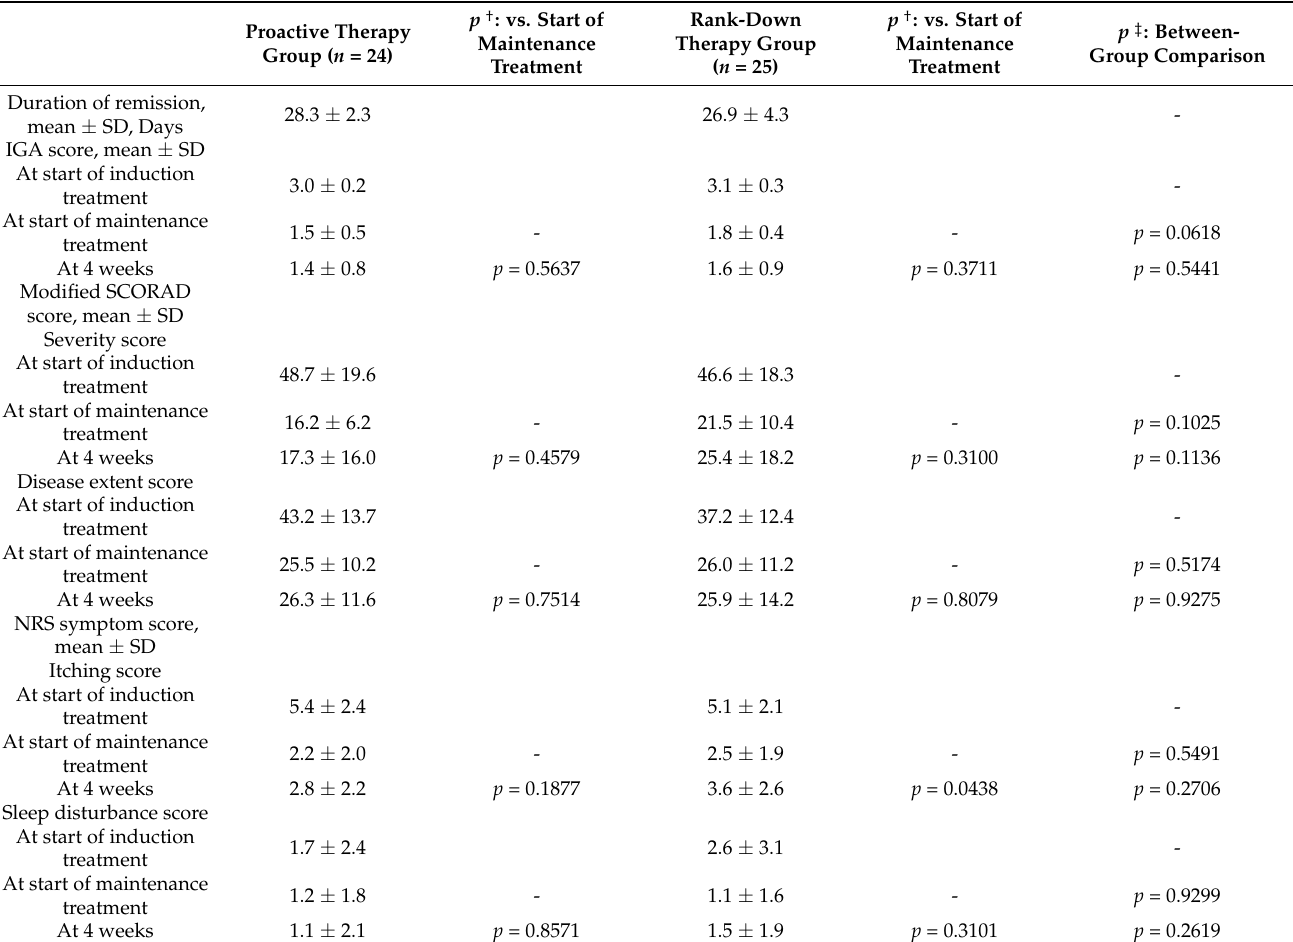
Table 2. Atopic dermatitis-related clinical outcome